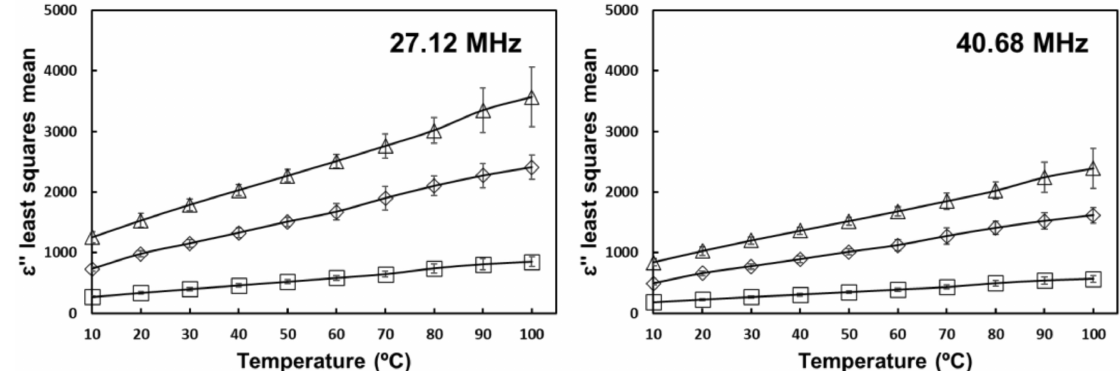
Figure 6. Temperature and salt interaction effect on the loss factor of tomato homogenate at 27.12 and 40.68 MHz. ( ) 0% salt ( ) 0.5% salt ( ) 1% salt. Error bars correspond to standard deviations.